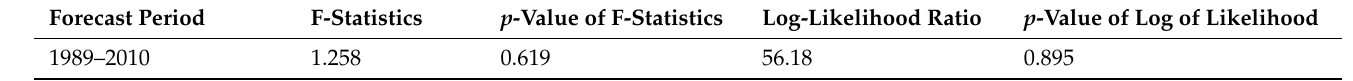
Table 8. Statistical output for the stability test (chow forecast